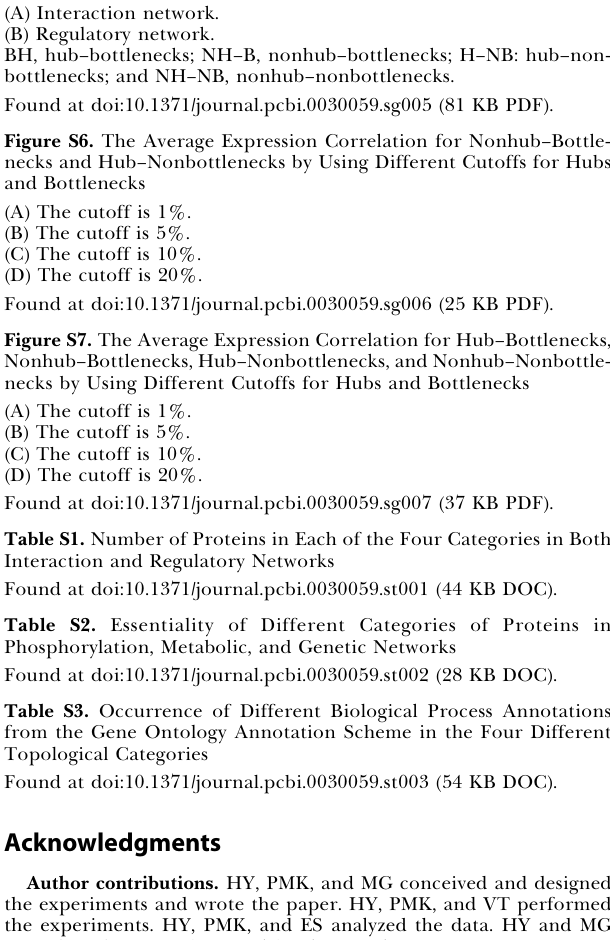
(A) Interaction network. (B) Regulatory network.